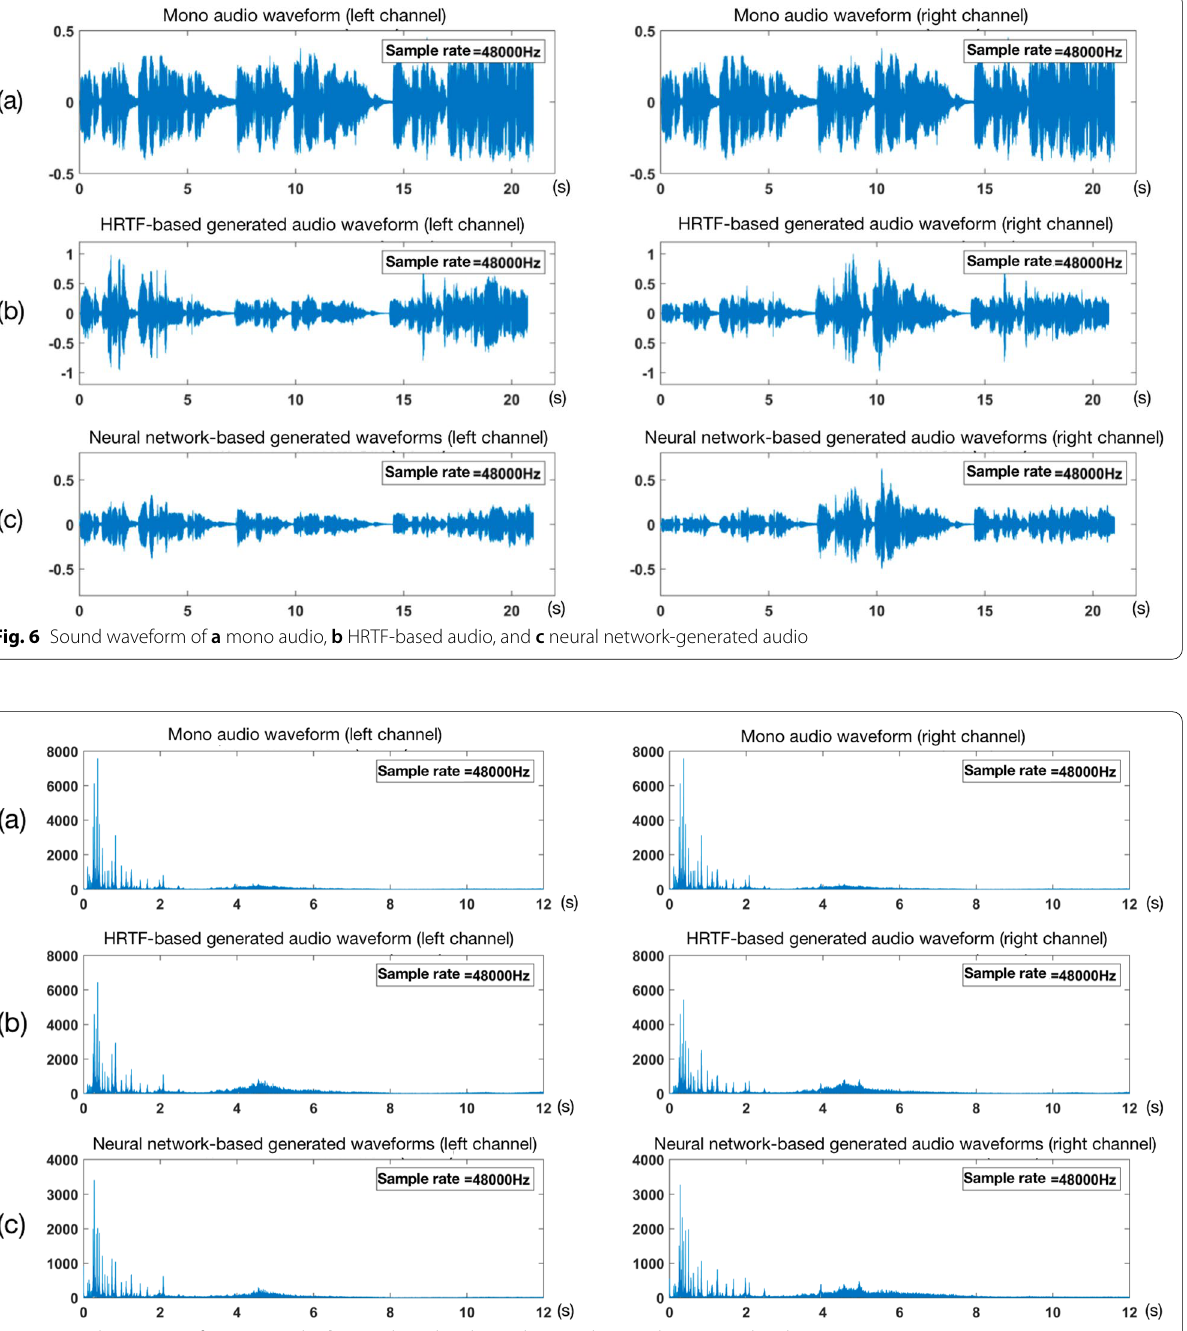
Fig. 7 Sound spectrum of a mono audio, b HRTF-based audio, and c neural network-generated